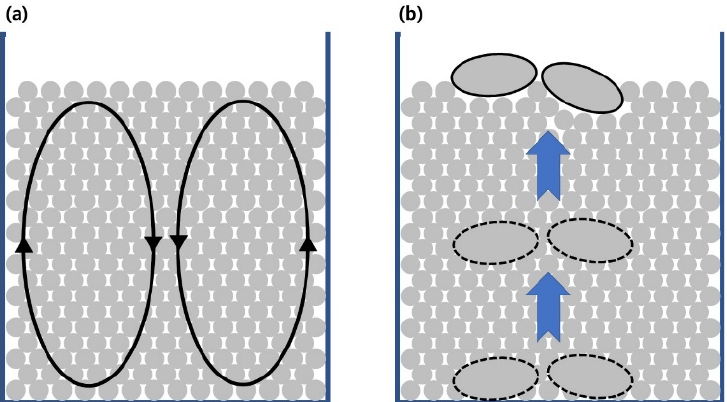
Figure 1. Schematic diagrams of ( a ) convection and ( b ) the ‘Brazil nut effect’ when vibrating a particle-filled vessel.